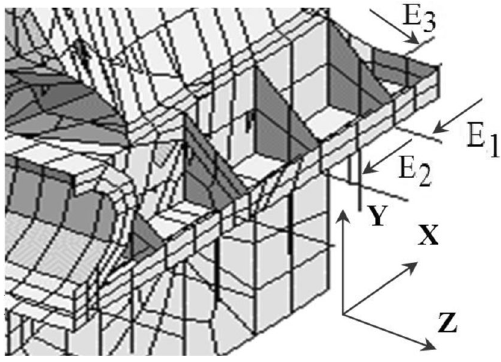
Fig. 7 The foundation system that models the foundation in a sim- plified calculation model